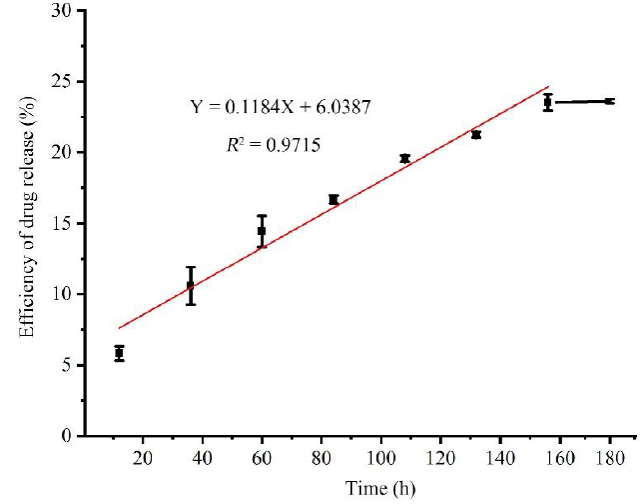
Figure 8. Release rates of loading drugs at different